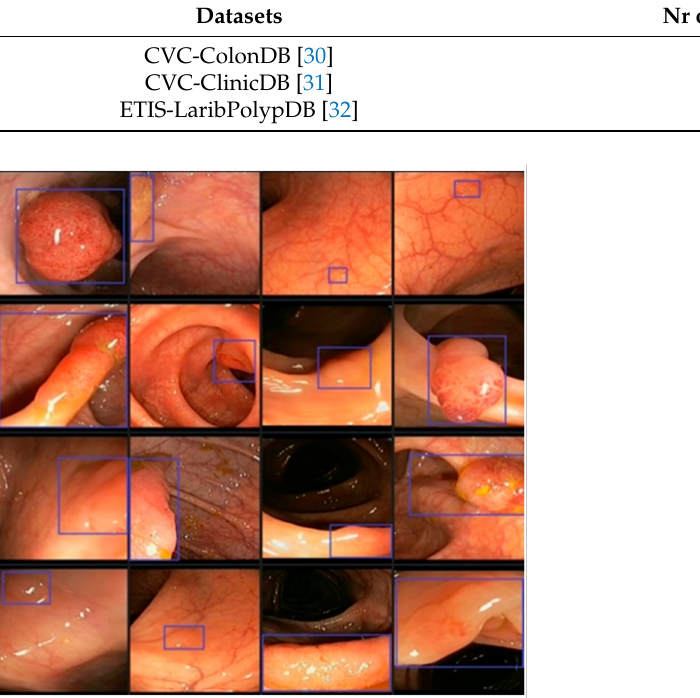
Figure 2. Different shapes and textures of colon polyps taken from colonoscopy